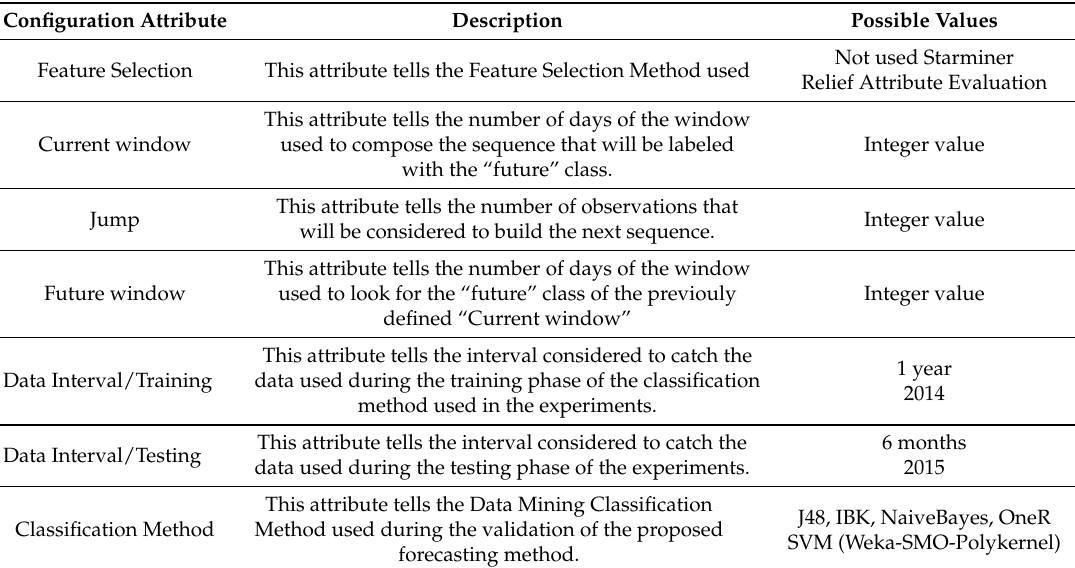
Table 7. Description of the attributes used in the